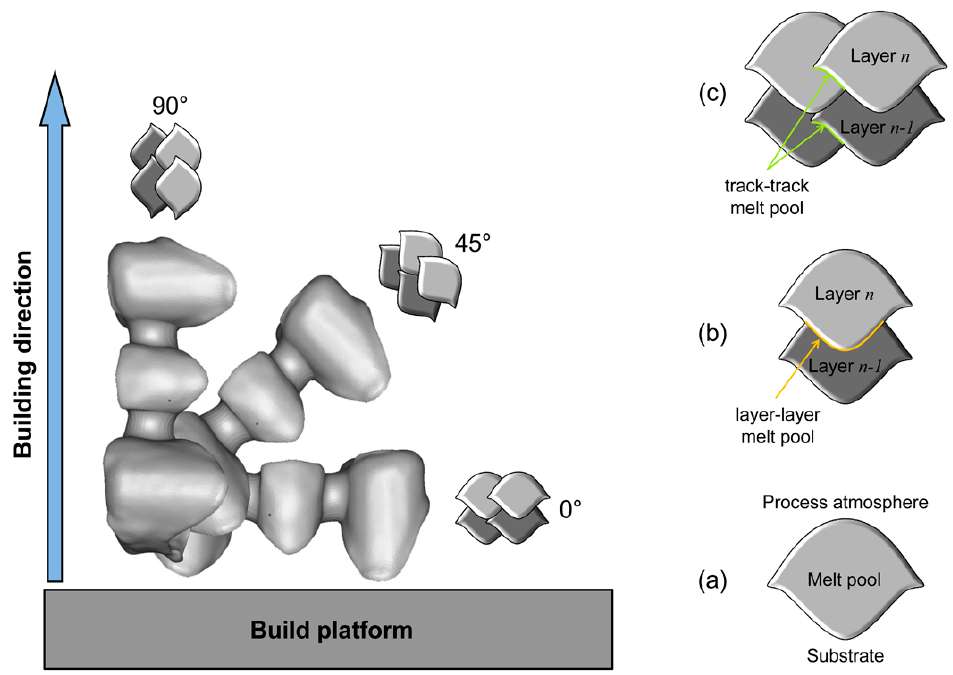
Figure 2. Processing strategies for the selective laser melting substructure of dental metal-ceramic restoration ( left ) and schematic representation of different types of molten pool boundaries (MPBs) ( right ): (a) single MPB; (b) “layer-layer” MPB; and (c) “track-track” MPB.